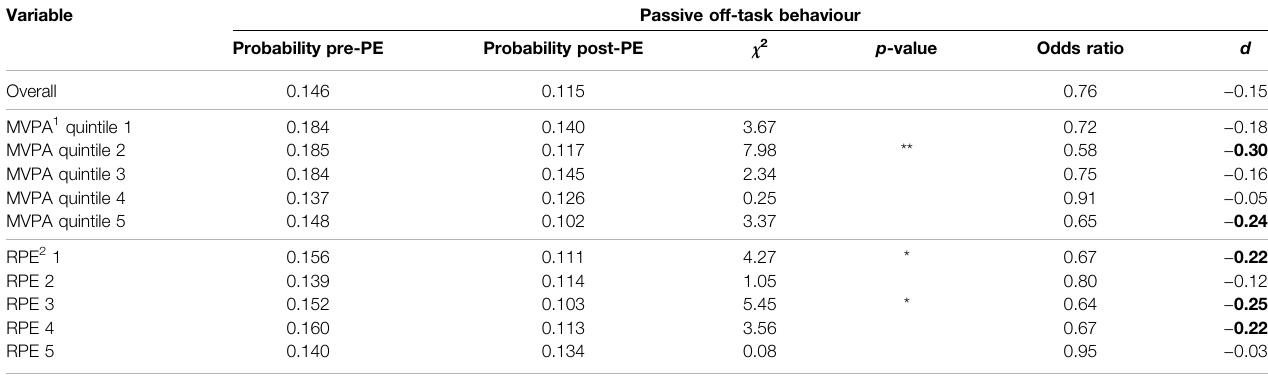
TABLE 4 | Response of passive off-task behaviour to objective and subjective PA. Variable